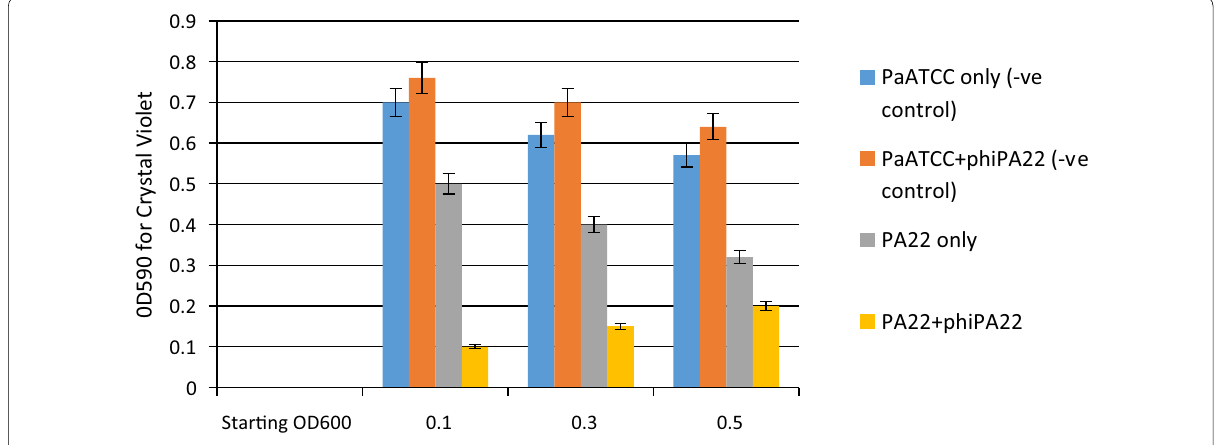
Fig. 8 Effect of ɸ ParuNE1phage on biofilms produced by P. aeruginosa CLI